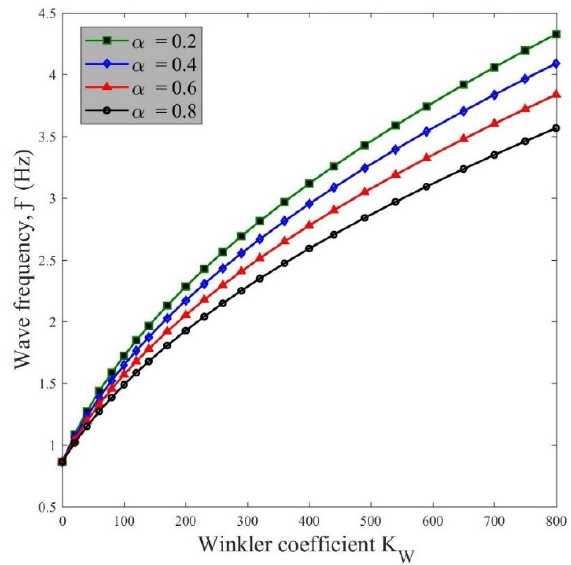
Figure 6. Wave frequency vs. Winkler parameter for various α .